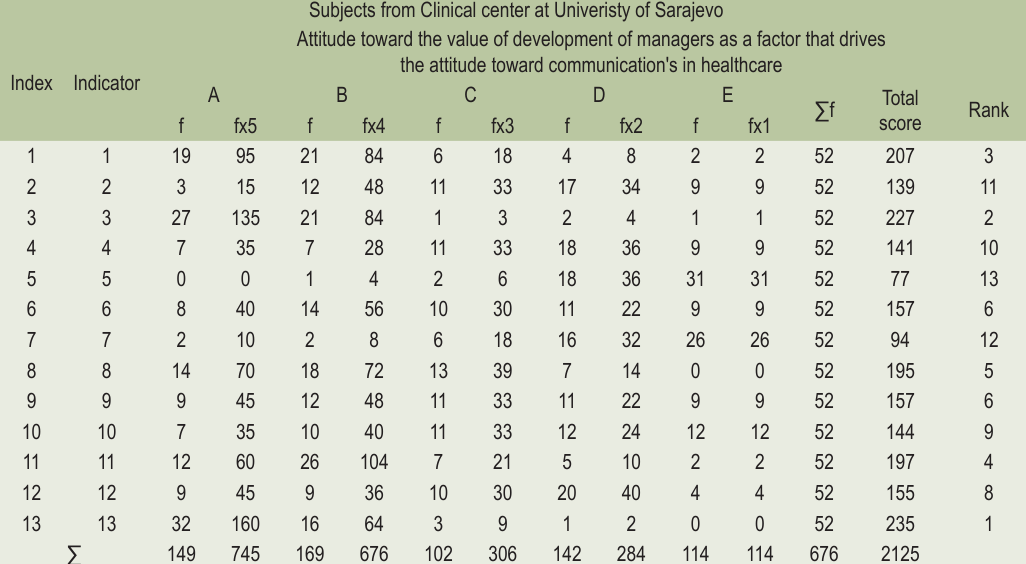
TABLE 2. Study results for Clinical center at University of Sarajevo